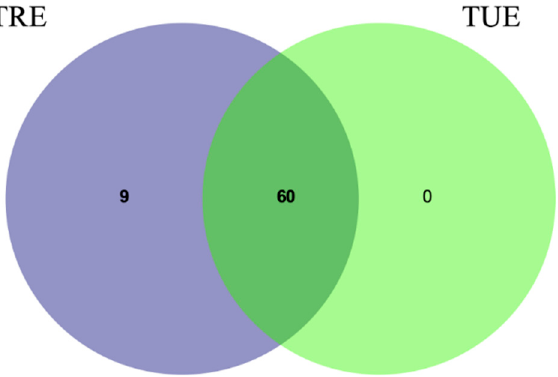
Figure 2. Venn diagram shows overlap of bacterial ASVs at the study end in TRE and TUE groups. Median changes in Lachnospiraceae, Parasutterella, and Romboutsia were significantly different between groups, with increased frequencies in the TRE group (Figure 3).